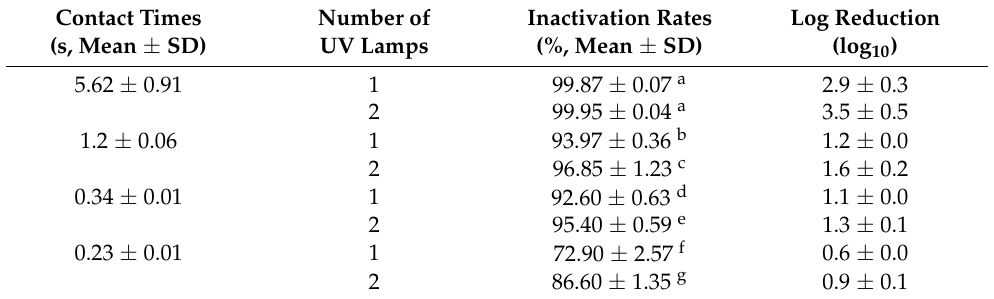
Table 3. Inactivation rates of UV light correspond to contact times and the number of UV lamps. Contact Times Number of (s, Mean ± SD) UV